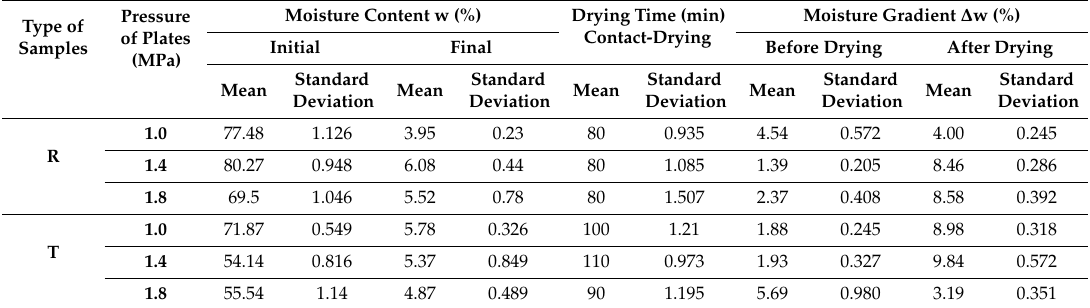
Table 1. Average values of moisture content, drying times and moisture gradients of samples. Type of